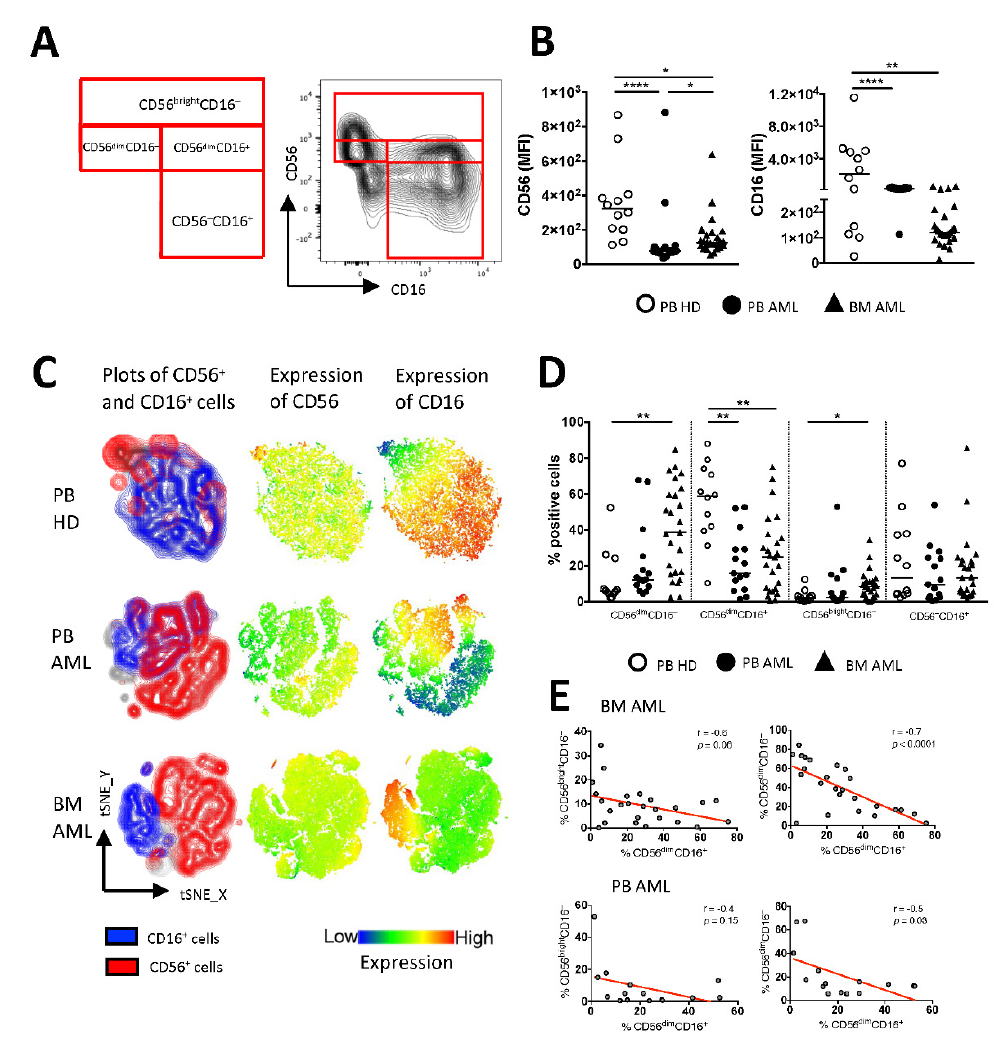
Figure 1. Increased frequencies of CD56 bright CD16 − and CD56 dim CD16 − cells are associated with a reduced CD56 dim CD16 + population in AML. Flow cytometric analysis of the expression of CD56 and CD16 on mononuclear CD3 – cells was performed for peripheral blood (PB, n = 15) specimens and bone marrow (BM, n = 25) aspirates from patients with acute myeloid leukemia (AML) and PB-derived CD3 – cells from healthy donors (HDs, n = 12). ( A ) The gating strategy and representative flow cytometry plots show the classification of the natural killer (NK) cell subpopulations. ( B ) Summary data illustrating the median fluorescence intensity (MFI) of CD56 and CD16. ( C ) The distribution of CD56 and CD16 is depicted in t-distributed stochastic neighbor embedding (tSNE) heat maps from 4 PB samples of HDs (upper graphs), 4 PB samples of AML patients (middle graphs), and 4 BM aspirates of AML patients (lower graphs). ( D ) Summary data show the frequency of CD56 dim CD16 − , CD56 dim CD16 + , CD56 bright CD16 − , CD56 – CD16 + NK cells from PB and BM aspirates of AML patients and PB of HDs. ( E ) Correlative analysis of the distribution of NK cell subpopulations was performed for BM- and PB-derived aspirates of the AML patients. p values were obtained by the ANOVA and Kruskal–Wallis test. * p < 0.05, ** p < 0.01, **** p < 0.0001. Pearson’s test was used to test for correlations.